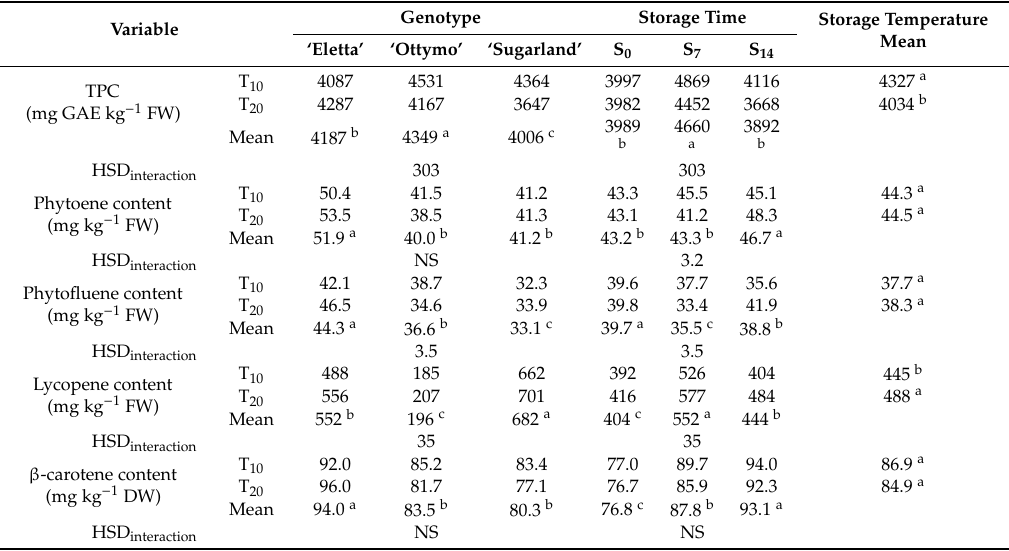
Table 6. Nutraceutical variables of cherry tomato as a ff ected by the main factors. Variable